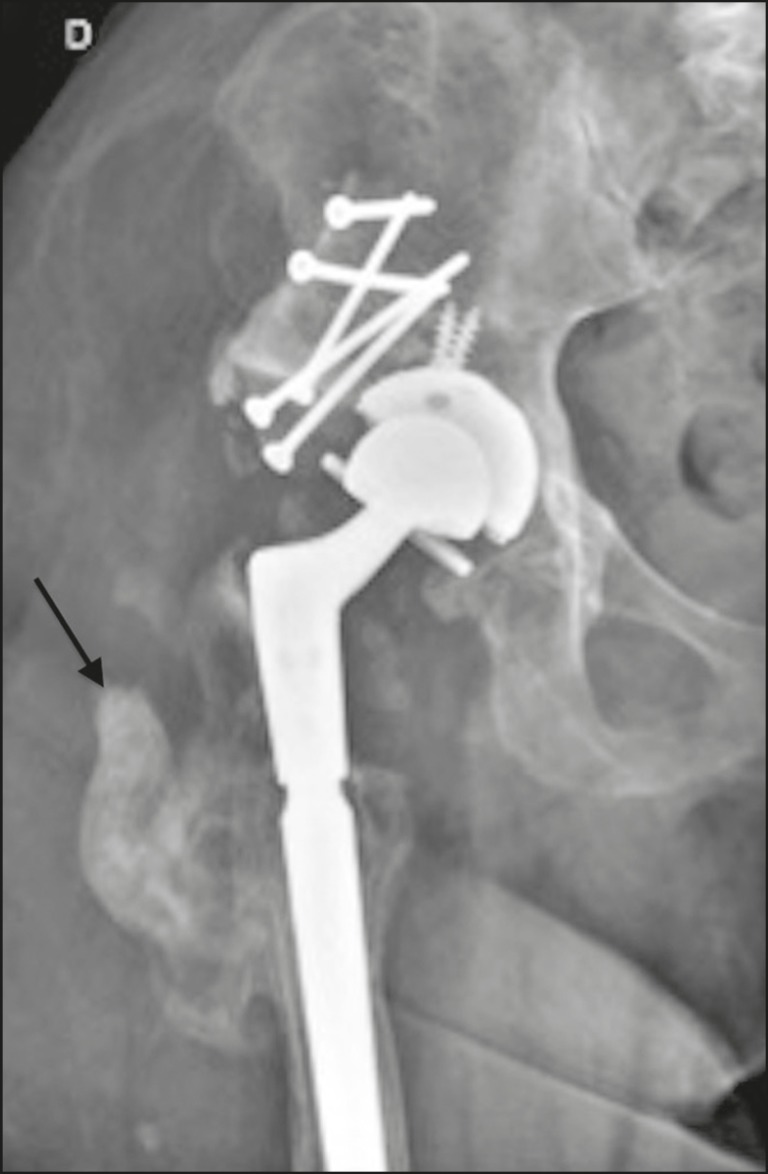
Anteroposterior X-ray of the right hip showing signs of total arthroplasty and bone grafting, with no signs of loosening. Grade III heterotopic ossification of soft tissue near the sites of surgical manipulation (arrow).